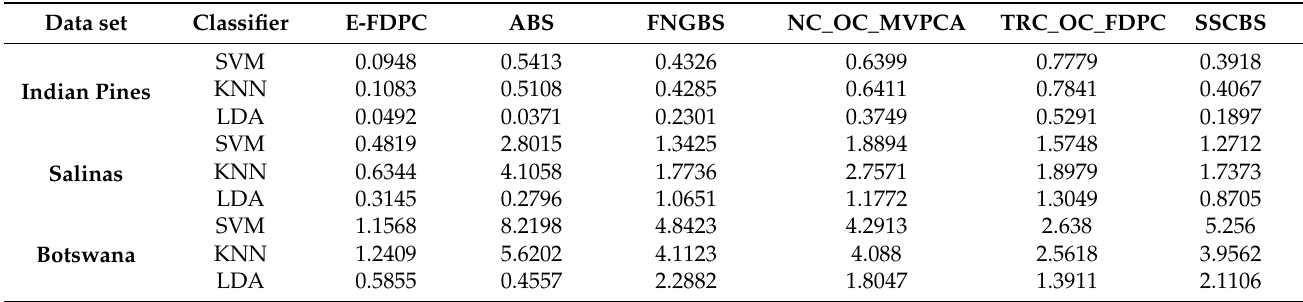
Table 3. Computational Time on Three Data